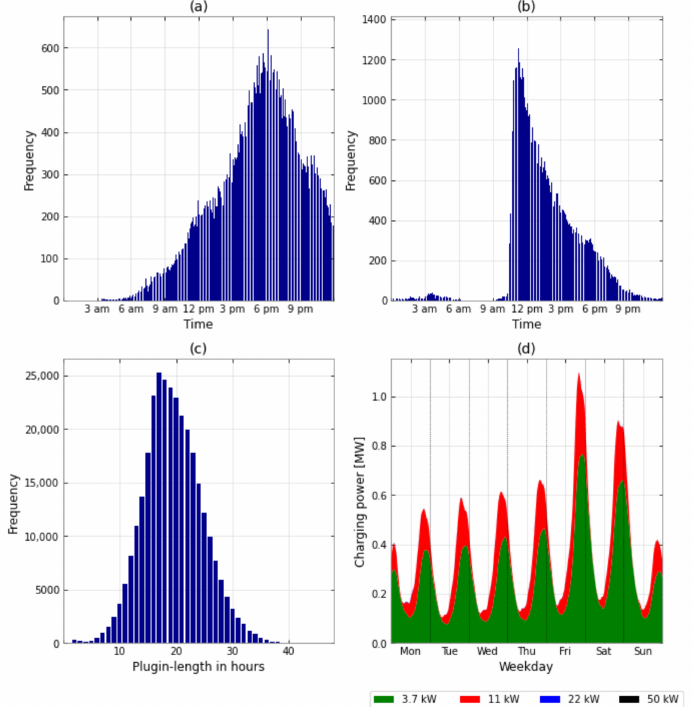
Figure A6. Charging characteristics of temporal charging cluster 4: ( a ) Frequency of different plug-in times; ( b ) Frequency of different plug-out times; ( c ) Frequency of different plug-in lengths; ( d ) Charging power